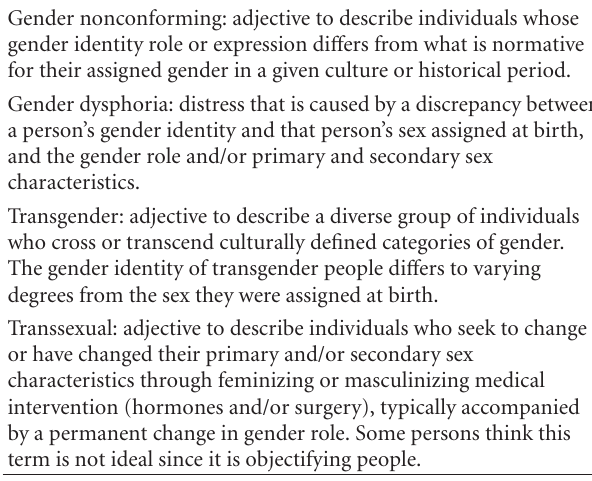
Table 1: Definitions